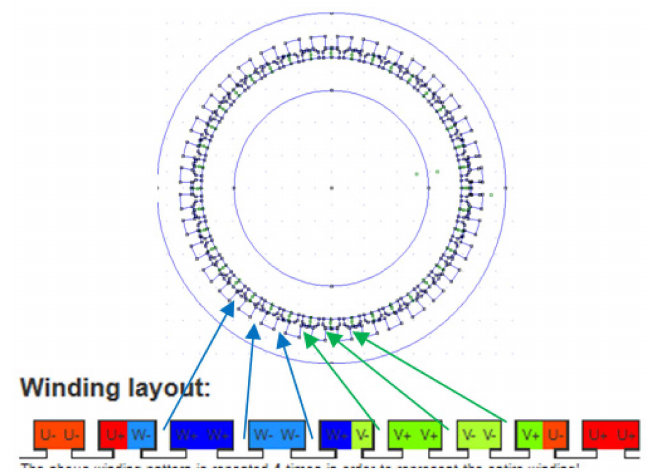
Figure 4. The structure of a generator having 40 poles and 36 slots is established in combining four times the basic winding layout. In the basic winding layout, the coils attached to the same phase are gathered three by three.